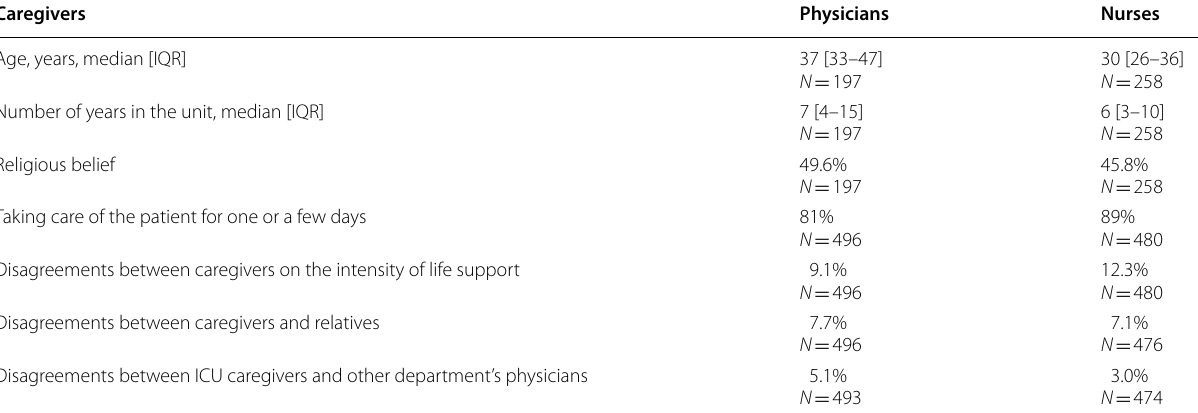
Table 2 Characteristics of caregivers